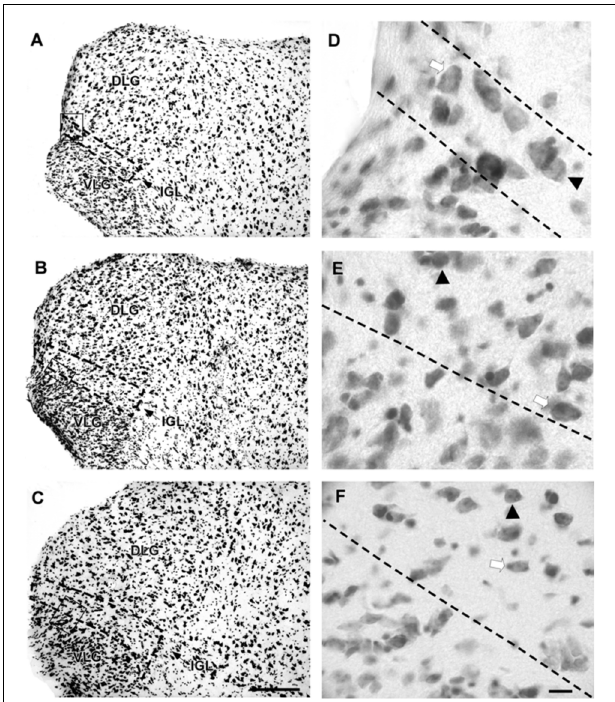
FIGURE 6 | Photomicrographs of the brain sections of flat-faced fruit-eating bat showing the components of the lateral geniculate complex in bright field (A–C) IGL stained by Nissl technique at rostral, middle, and caudal levels, respectively. The boxed areas in (A–C) are shown in high magnification in (D–F) , respectively. Black arrowheads point to spherical neurons. White arrow points to oval cells. Scale bar 100 µ m (A–C) and 10 µ m (E,F)